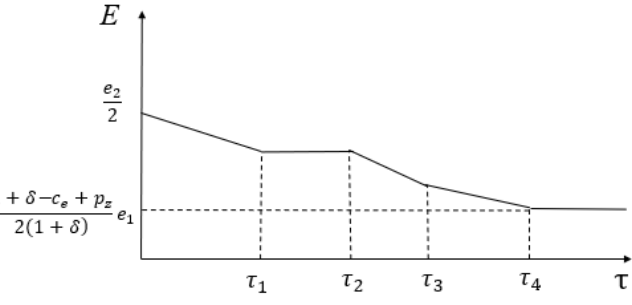
Figure A3. Changes in environmental impact under production regulation